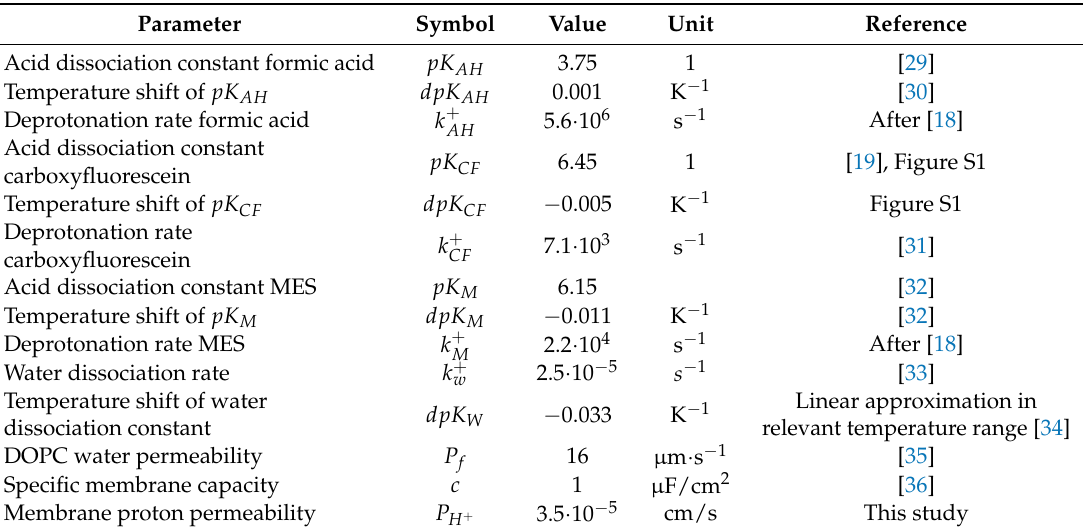
Table 1. Values of parameters used for